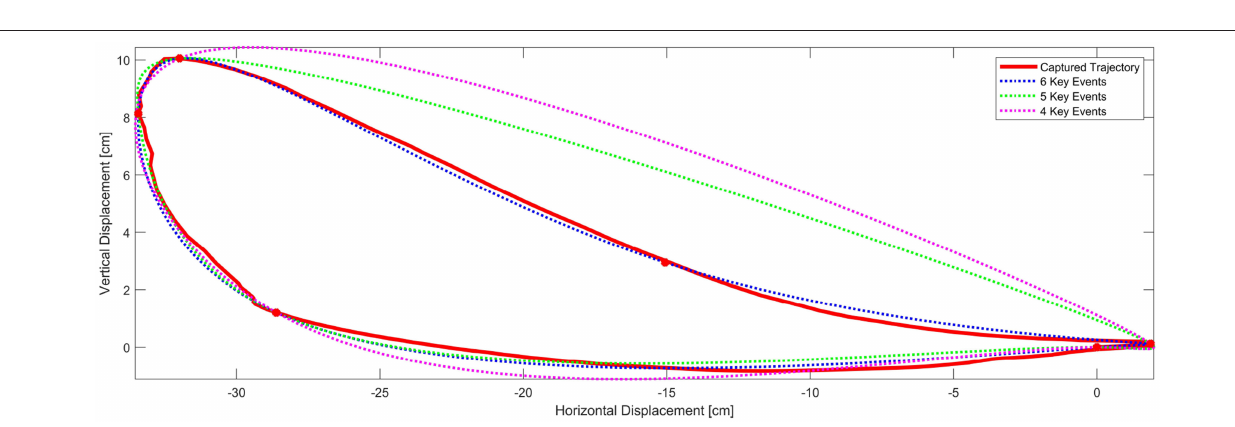
2D plane to make the analysis more understandable and useful. The centroids are the average point of all key events of the same type and the same trial for all subjects. The representation of each key event per test was found as: ellipse centroid per trial i.e., there is one set of 6 centroids